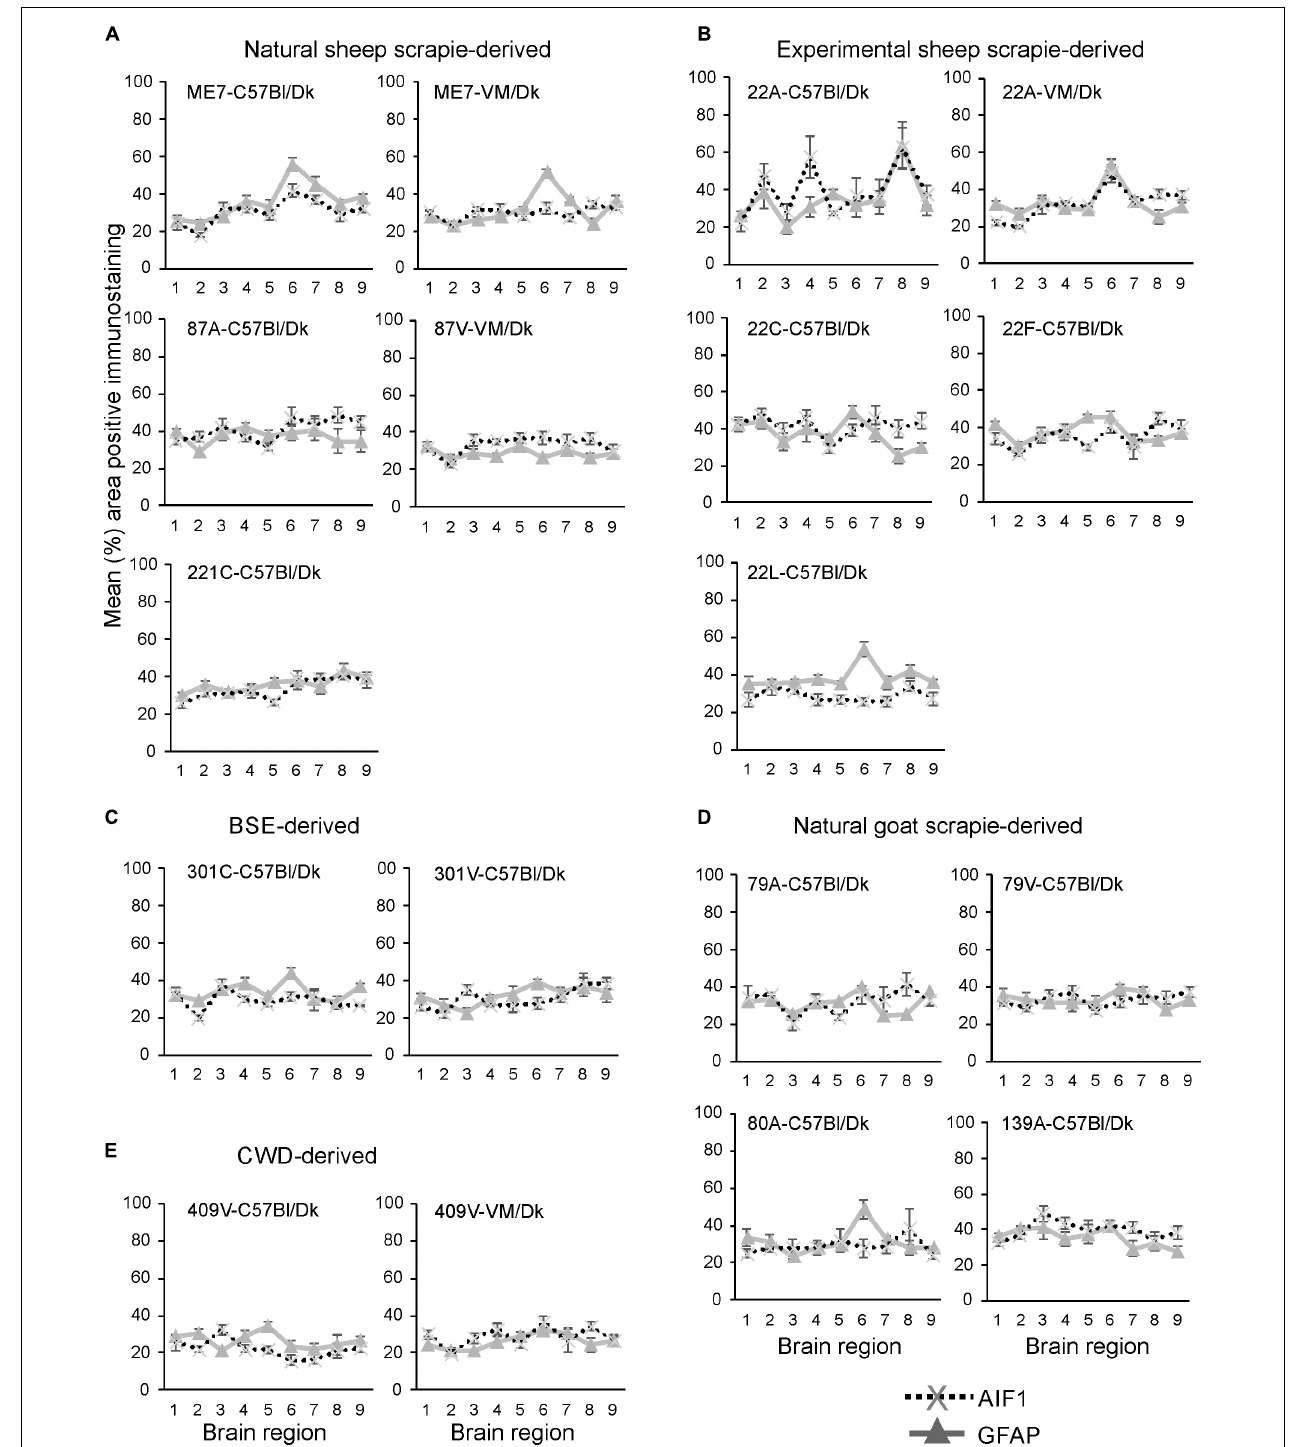
FIGURE 6 | (A–E) Comparison of the magnitude and distribution of the GFAP + and AIF1 + immunostaining in the brains of mice infected with a variety of distinct prion agent strains. Groups of C57Bl/Dk or VM/Dk mice were injected intracerebrally with a variety of distinct prion agent strains ( Table 1 ). Brains were collected at the terminal stage of disease and immunostained to detect GFAP + cells (astrocytes) and AIF1 + cells (microglia). The percentage area coverage of each marker was then compared in each of the following gray matter brain regions G1, dorsal medulla; G2, cerebellar cortex; G3, superior colliculus; G4, hypothalamus; G5, medial thalamus; G6, hippocampus; G7, septum; G8, cerebral cortex; G9, forebrain cerebral cortex. N = 6 mice/group. Data represent mean ± SE, from a minimum of 54 images/group.